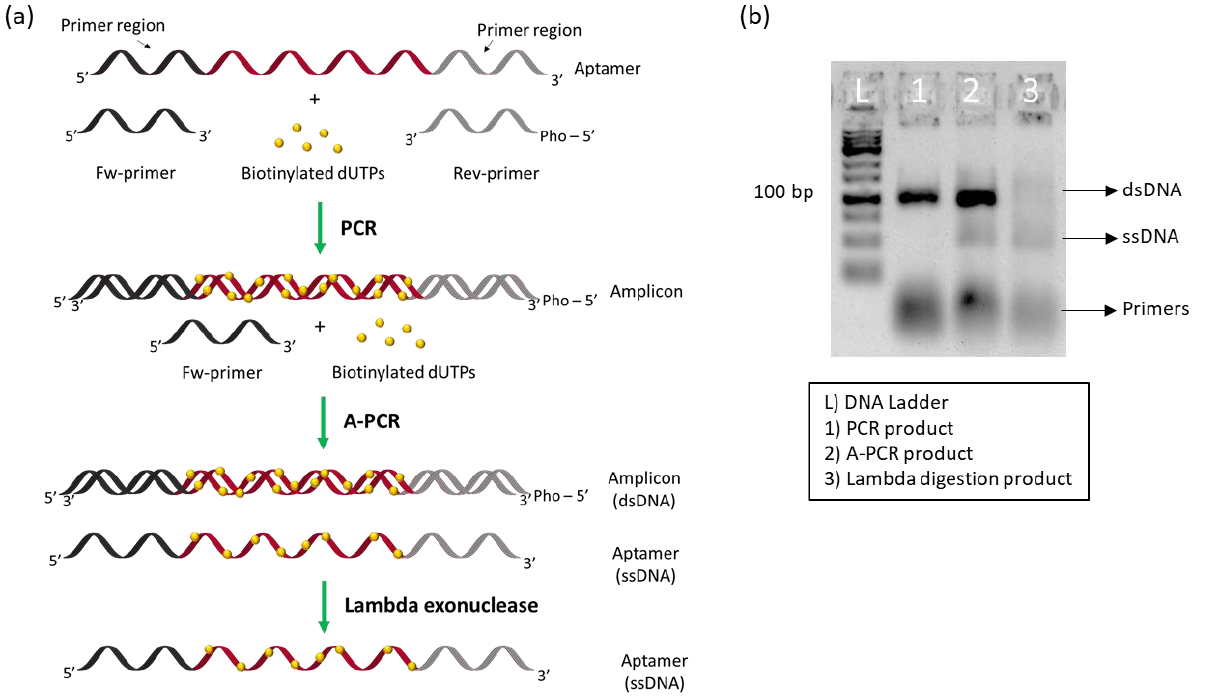
Figure 1. Aptamer preparation using biotinylated dUTPs: ( a ) schematic representation of the pre- pared aptamer; ( b ) agarose gel, showing the different steps needed for the modified aptamer.